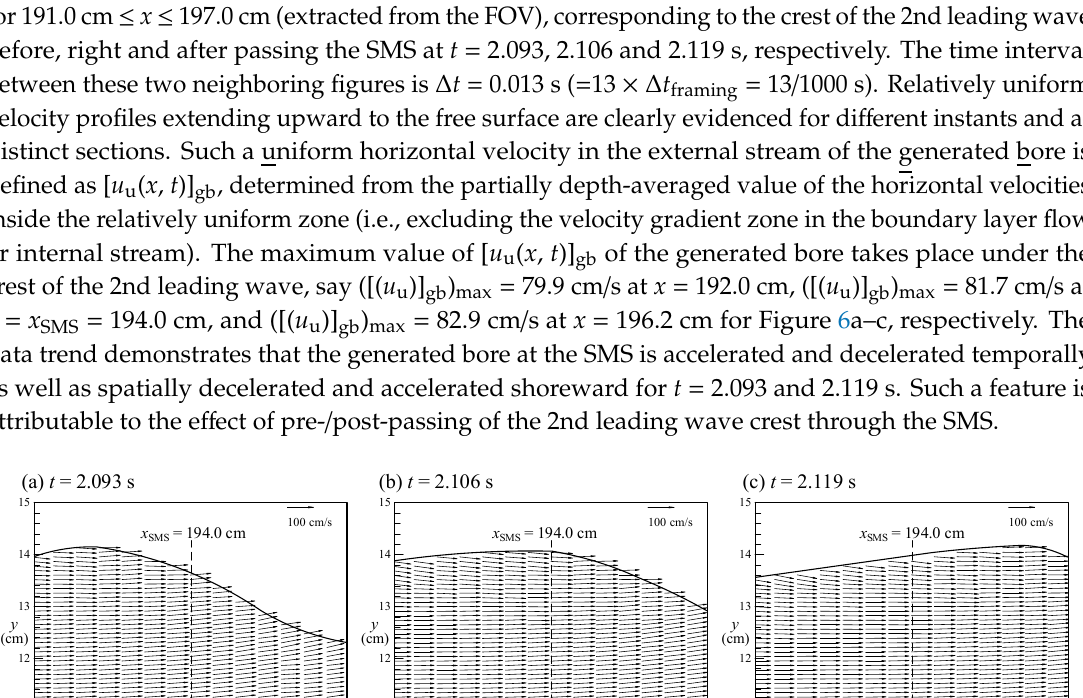
Figure 5. Spatial variation of breaking point x bpn for n th leading wave (with n = 1–4).